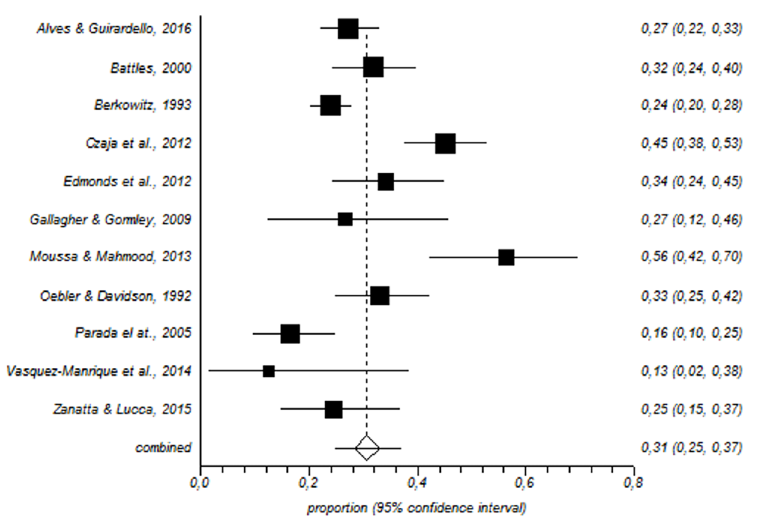
Fig 2. Forest plot for high emotional